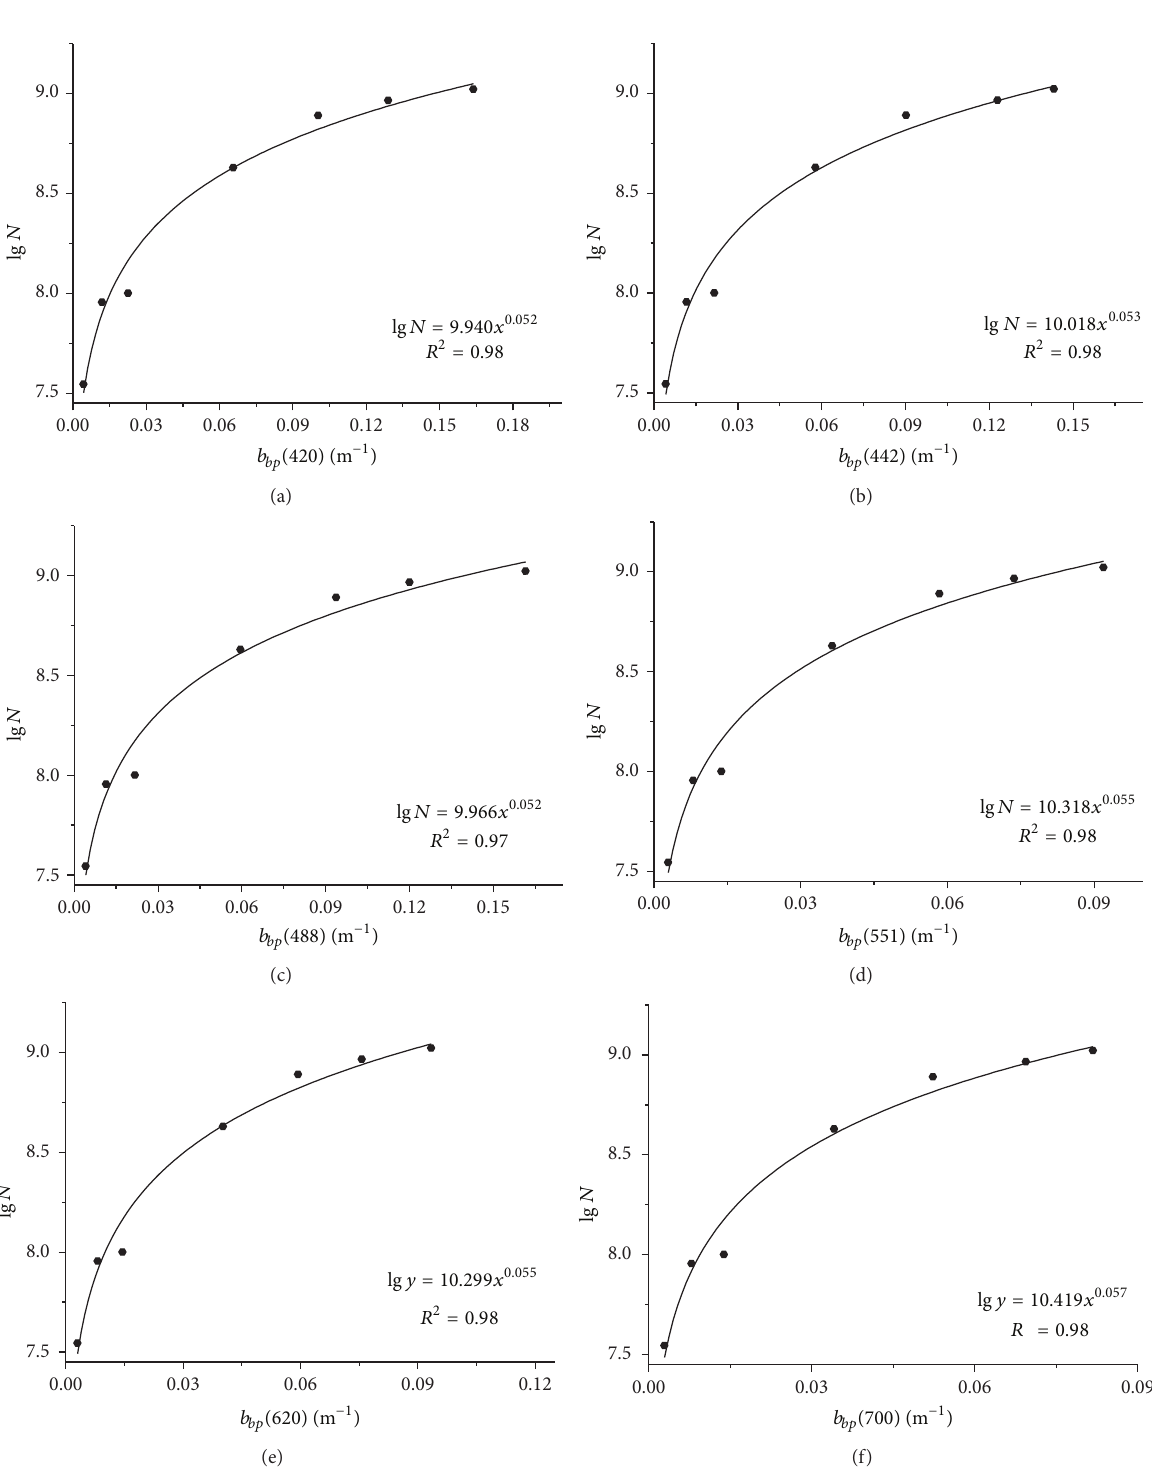
Figure 4: Particle backscattering coefficients versus cell density at six other wavelengths for Aureococcus anophagefferens . (a) 420 nm. (b) 442 nm. (c) 488 nm. (d) 550 nm. (e) 620 nm. (f) 700